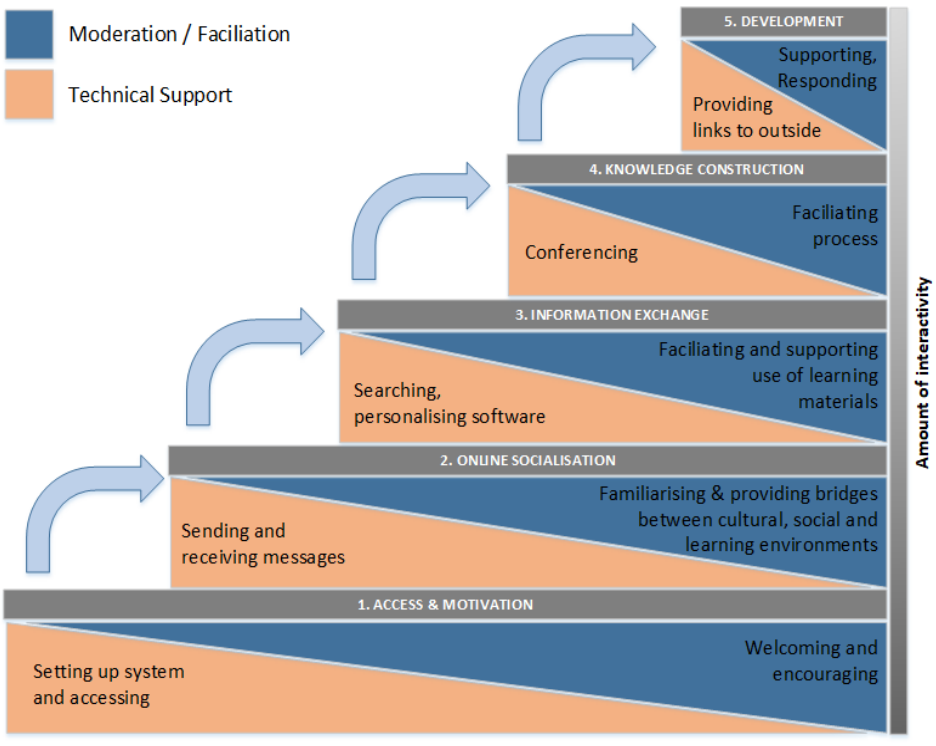
Figure 1. Salmon’s five-stage model for online learning. Gilly Salmon–E-tivities: The key to active online learning (2013) according to [16–19]. This image is available under the Creative Commons Attribution-NonCommercial-NoDerivatives 4.0 International (CC BY-NC-ND 4.0) license as stated in the publication and on the website of the author: https://www.gillysalmon.com/contact.html (accessed on 9 March 2022).